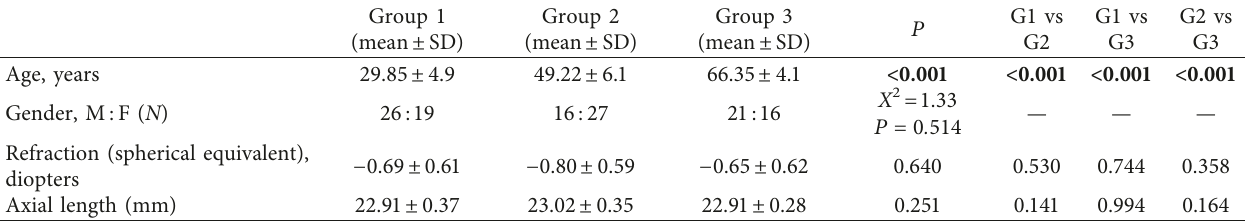
Table 1: Demographic and ocular characteristics of the 3 studied groups’ participants.